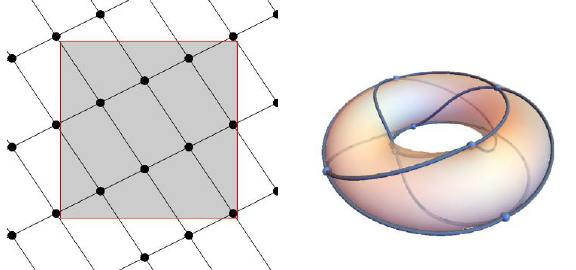
Figure 9. The (ramified) drawings of the Möbius–Kantor graph G ( 8,3 ) . 3.